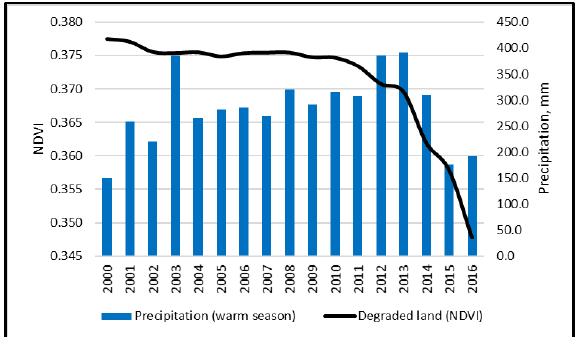
Figure 5b. The temporal variation between degraded land and precipitation.